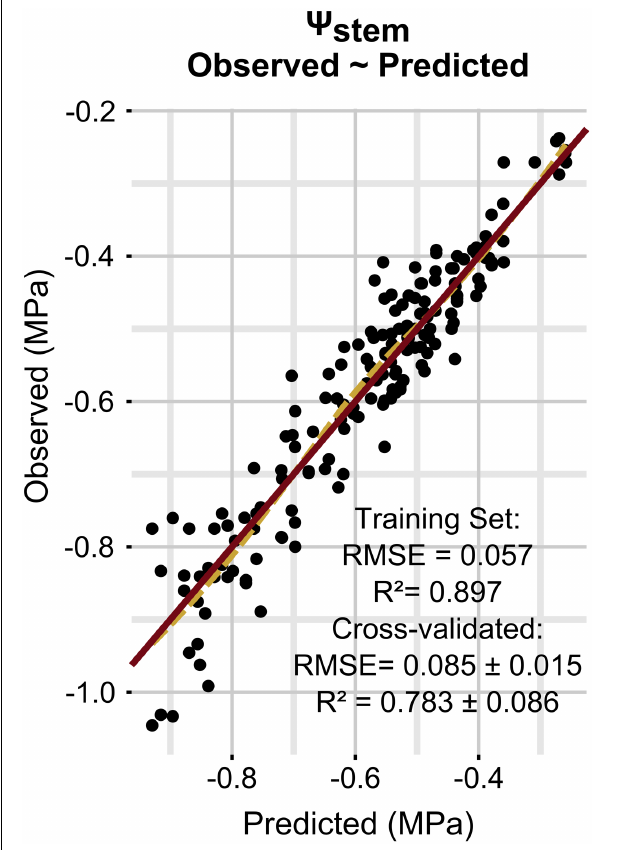
FIGURE 1 | Relationships between observed and predicted (cid:57) stem data (training dataset is shown). The solid line is a line with slope 1 and intercept 0, while the dashed line is a loess fitted to the data.